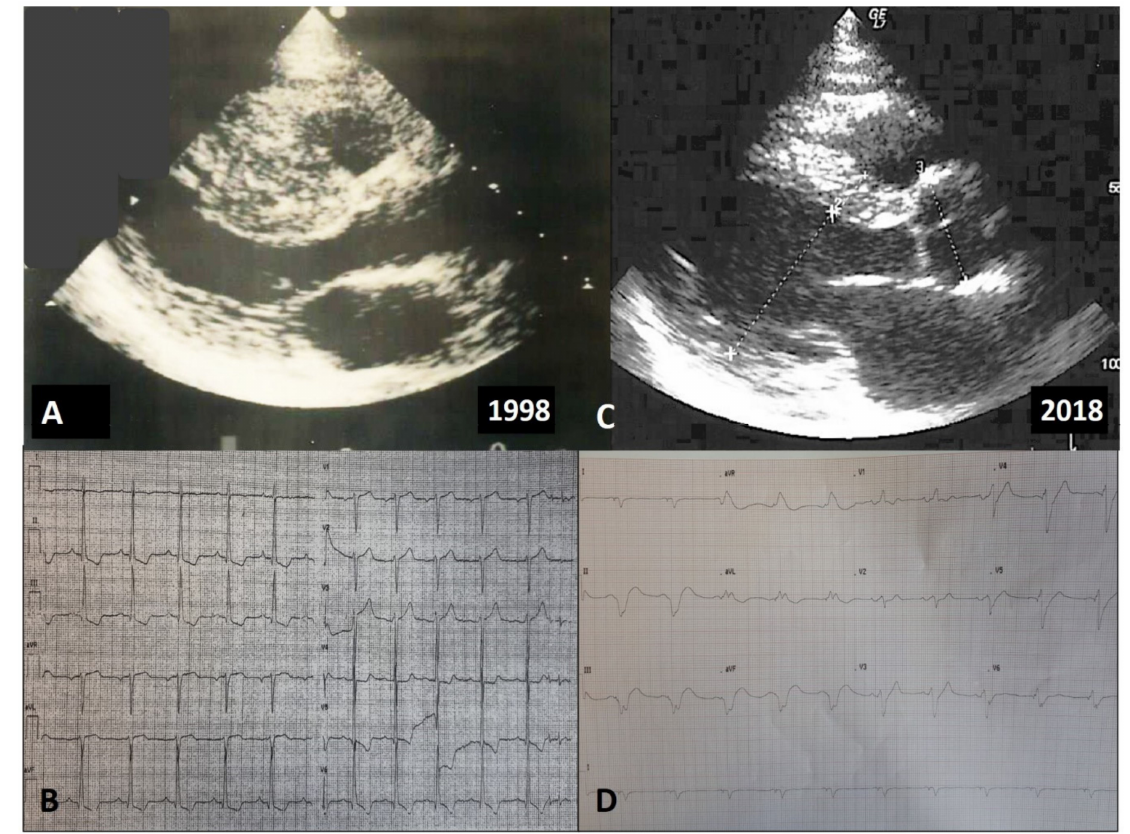
Figure 5. Echocardiographic and electrocardiographic findings in a patient with adverse LV remodeling, characterized by LV wall thinning and loss of systolic function. This is the case of a 38-year-old male with familial HCM. At first evaluation, the echocardiogram showed a maximal wall thickness of 27 mm at the level of the anterior septum ( A ), and the electrocardiogram showed signs of LV hypertrophy ( B ). After 20 years, he had an episode of decompensated heart failure. At admission in our cardiology ward, the echocardiogram showed a reduction in maximal wall thickness, which was 14 mm at the level of the anterior septum, and an enlargement of the LV cavity, with impaired systolic function (LV ejection fraction 20% ( C )). The electrocardiogram showed sinus rhythm, first-degree atrioventricular block, extreme left axis deviation, right bundle branch block, and reduction in voltages ( D ). He underwent implantation of a biventricular cardioverter defibrillator. Coronary angiogram was normal. After 1 year, the patient died while enlisted for heart